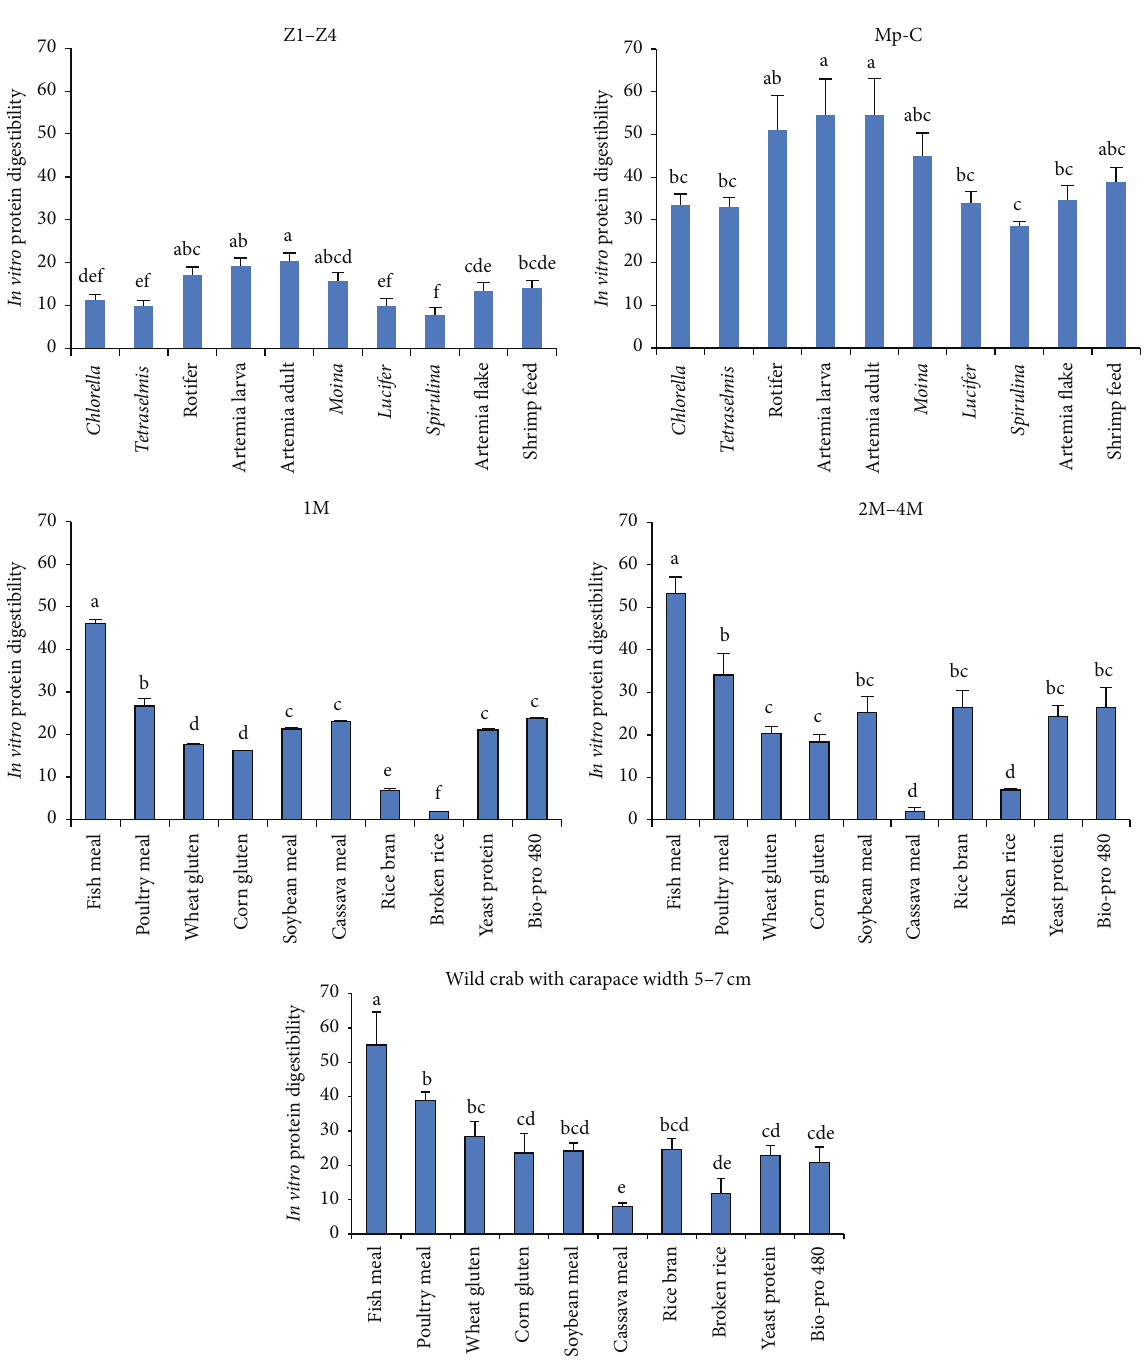
Figure 4: In vitro protein digestibility ( 𝜇 mol DL -alanine equivalent g −1 of dried raw material trypsin activity −1 ) of different feed raw materials using crude enzyme extracts from different stages of cultured P. pelagicus (zoea, Z1–Z4; megalopa, Mp; first crab, C; adult stages, 1M–4M) and wild adult P. pelagicus . The bars with different superscripts are significantly different ( 𝑃 < 0.05 ).